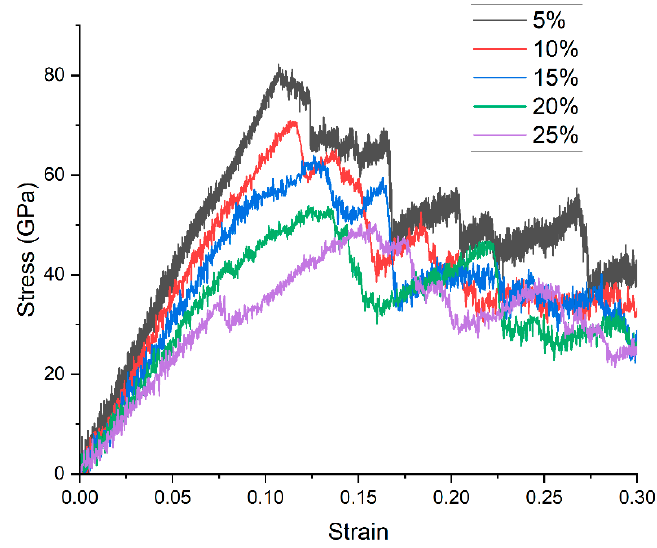
Figure 5. Stress-strain curve of GO with different functional groups density.